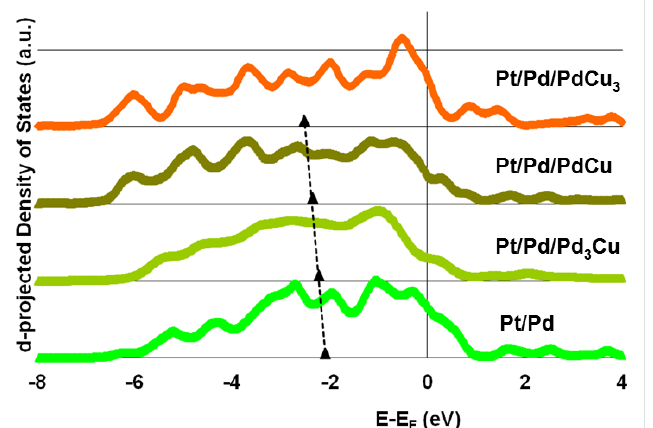
Figure 4. Calculated d-projected density of states of Pt mono-layer for Pd/Pd substrates and Pt metal. The Fermi level is set at zero. The position of d-band center, marked by black triangles, shift away from Fermi level for Pt on mixed Pd